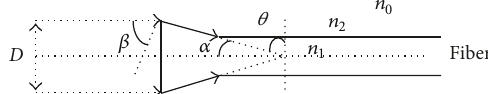
0.20.40.60.81.0